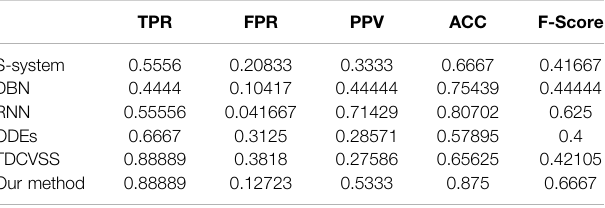
TABLE 1 | Performance comparison of six methods for the SOS network.